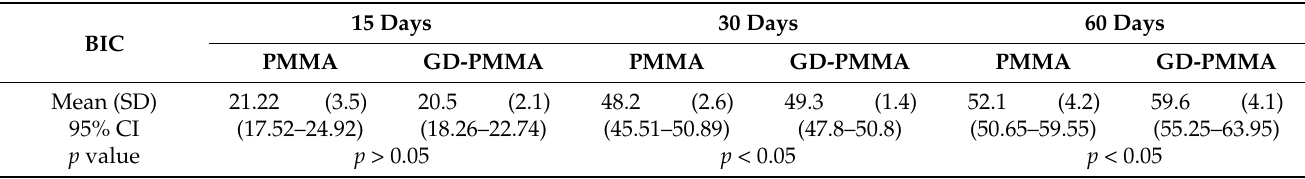
Figure 5. A GD-PMMA implant. ( A ) Lamellar bone (LB) in direct contact with the implant. Acid fuchsin-toluidine blue 12X ( B ) Mature bone (LM) in close contact with the implant, no osteoblasts or macrophages are observed. Acid fuchsin-toluidine blue 50X ( C , D ) Micro-C shows mineralized bone in direct contact with the implant. Table 1. Summary of histomorphometric bone-to-implant contact percentage (BIC%) between the PMMA implants group and GD-PMMA implants group (Kruskal Wallis followed by the Bunn’s test).